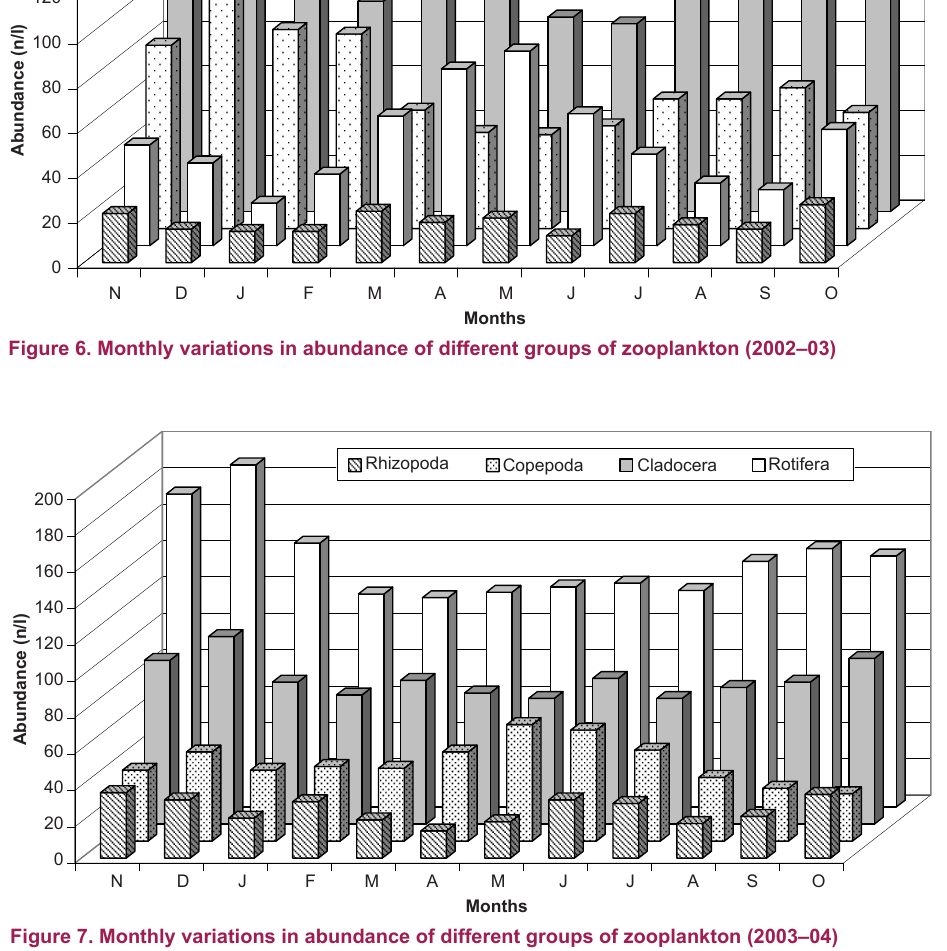
Figure 7. Monthly variations in abundance of different groups of zooplankton